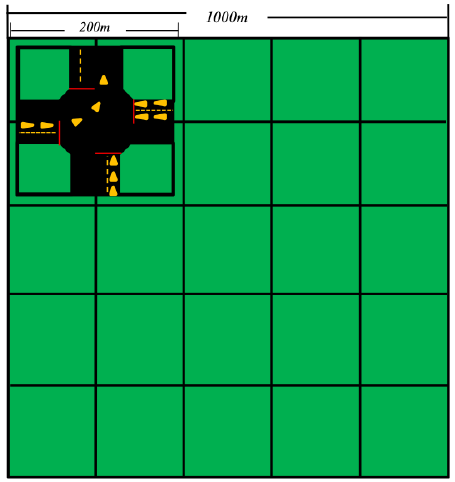
Figure 5. Road network, 5 × 5 Manhattan grid. Table 6. Simulation